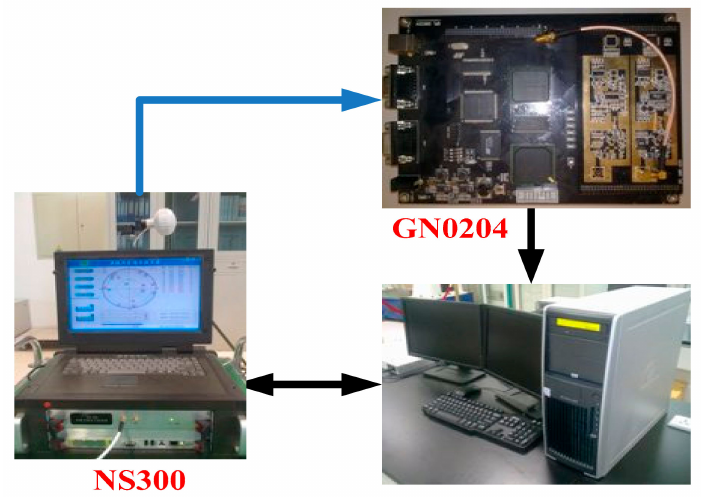
Figure 2. Structure of the highly-dynamical scene experiment